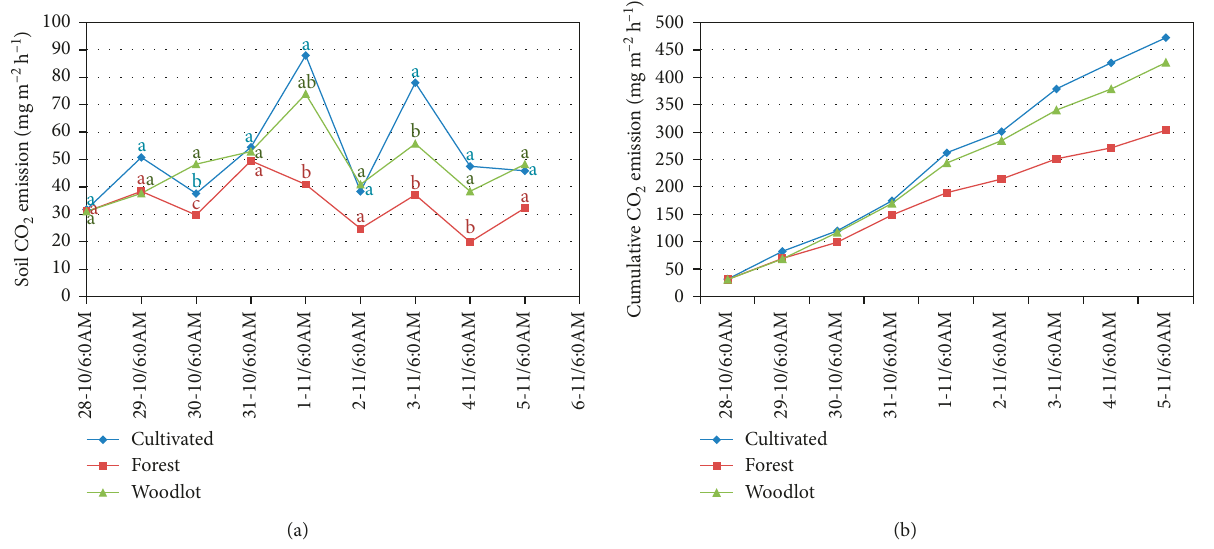
Figure 5: Temporal (a) and cumulative (b) CO 2 emission from different land-use at Legon farm site.